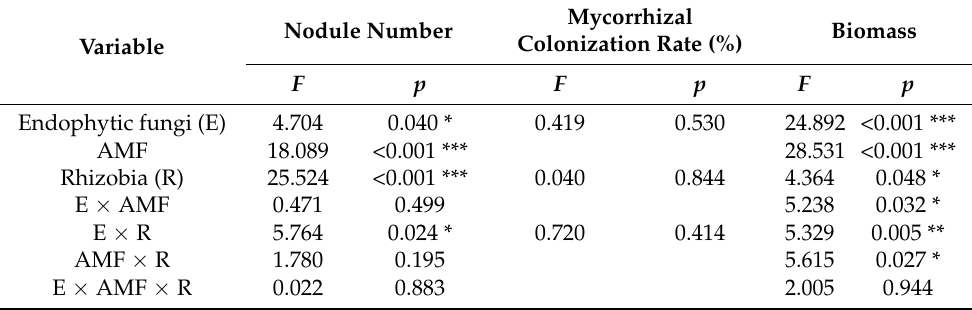
Table 1. ANOVA of the influence of endophytic fungi, arbuscular mycorrhizal fungi (AMF) and rhizobia on nodule number, mycorrhizal colonization rate (%) and biomass of Trifolium repens.